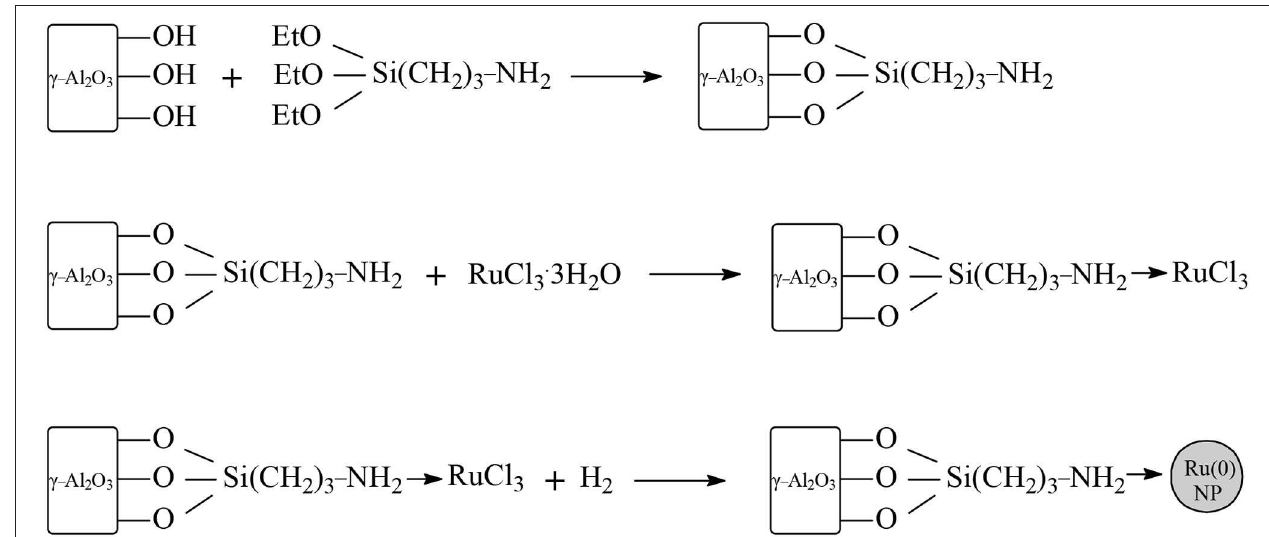
FIGURE 7 | Synthesis of the Ru/NH 2 - γ -Al 2 O 3 catalytic system.